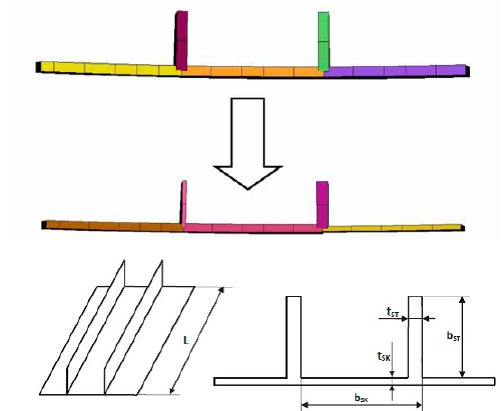
Fig. 6. An example of the thickness optimization of panel skins and